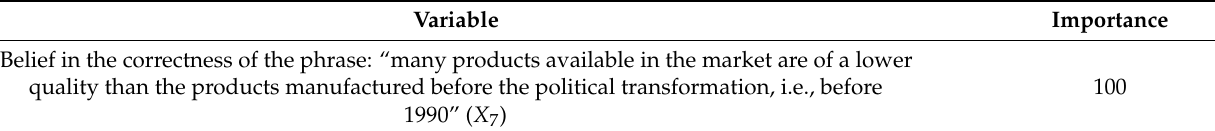
Table 8. Ranking of importance of variables relating to